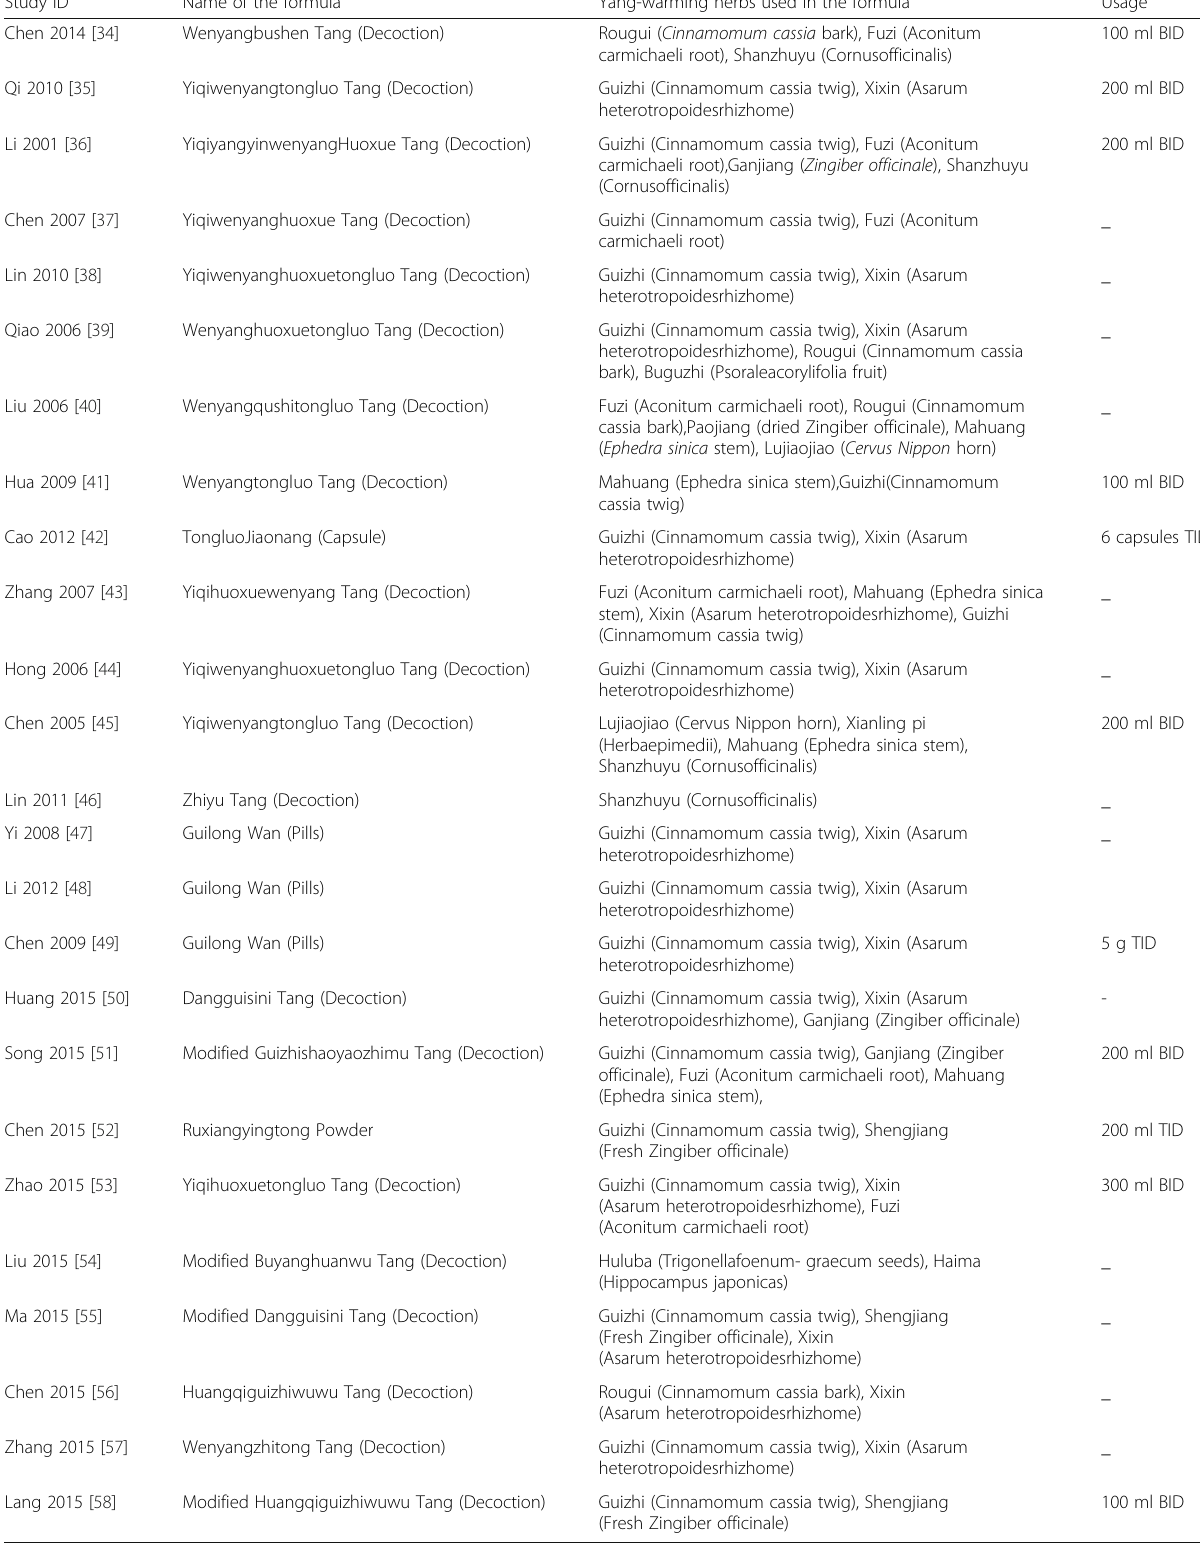
Table 3 Yang-warming Chinese herbs included in the studies Study